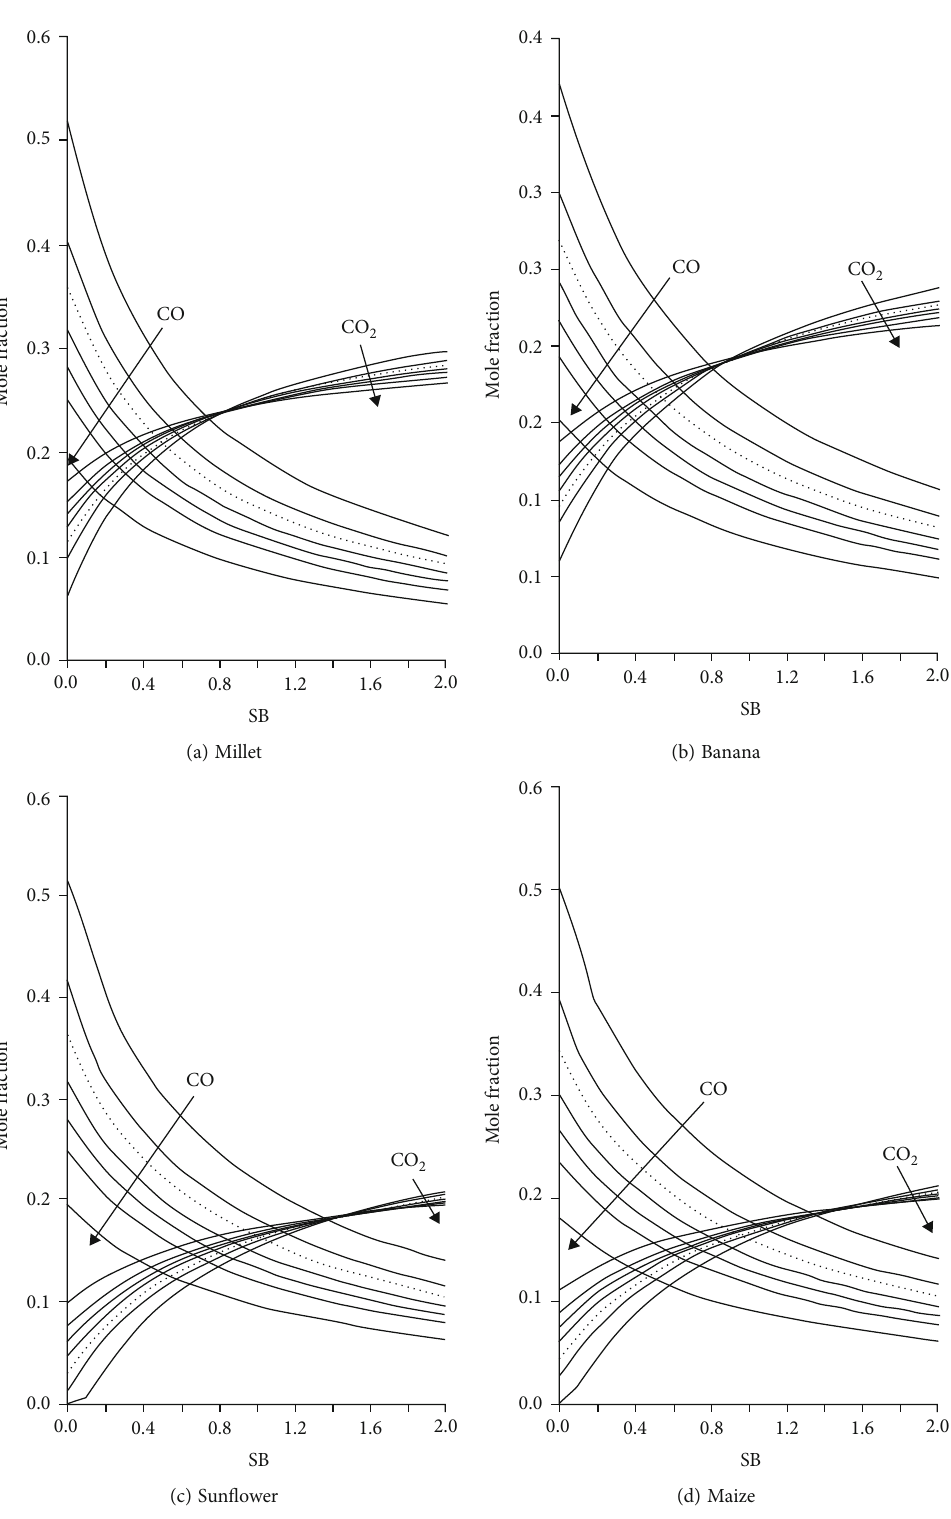
Figure 4: CO and CO concentration vs. ER and SB. Dotted curves at ER = 0 : 15 . The arrow indicates increasing 2